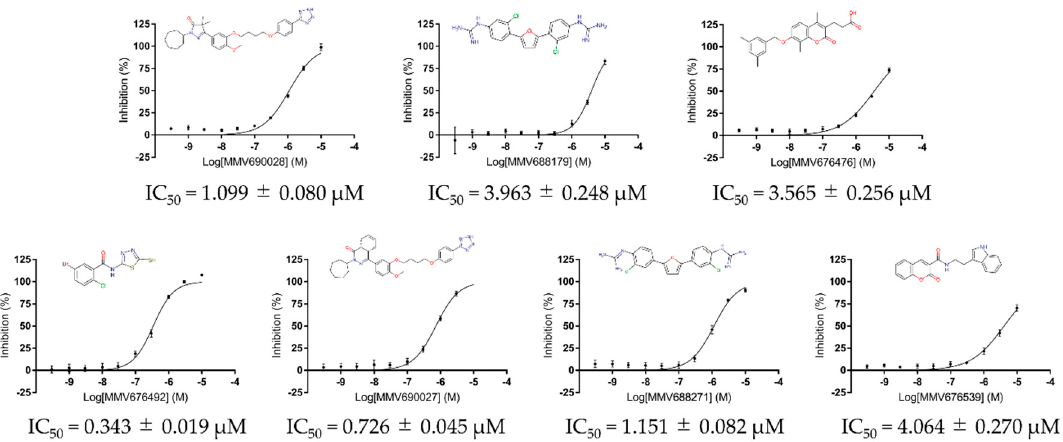
Figure 3. The IC 50 against recombinant PfMQO and the chemical structure of each hit identified from the Pathogen Box.